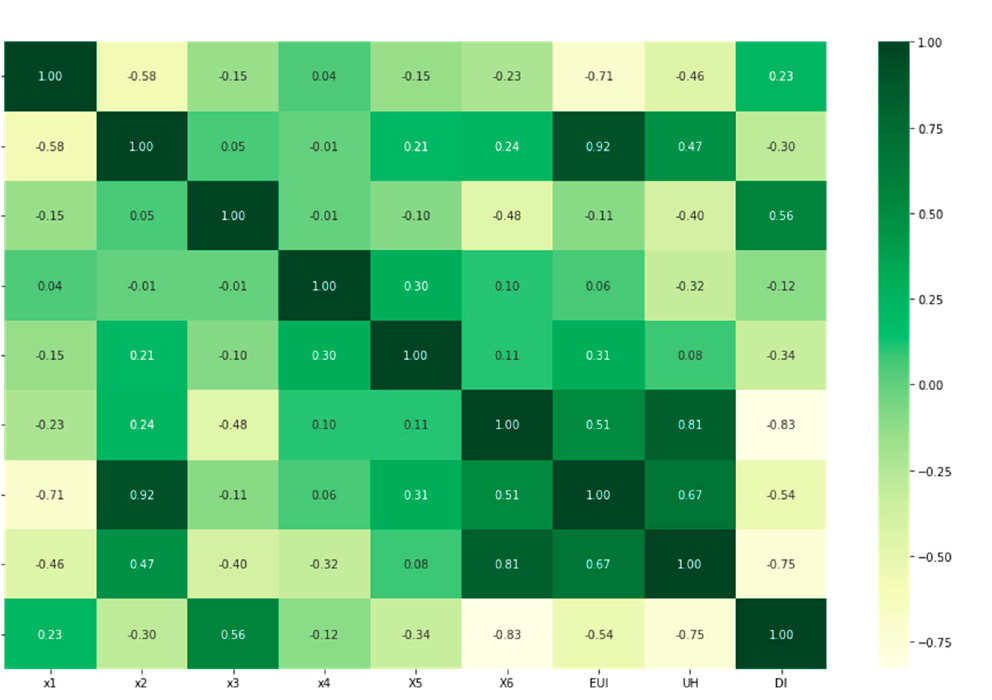
Figure 10. Correlation analysis between design parameters and performance objectives.